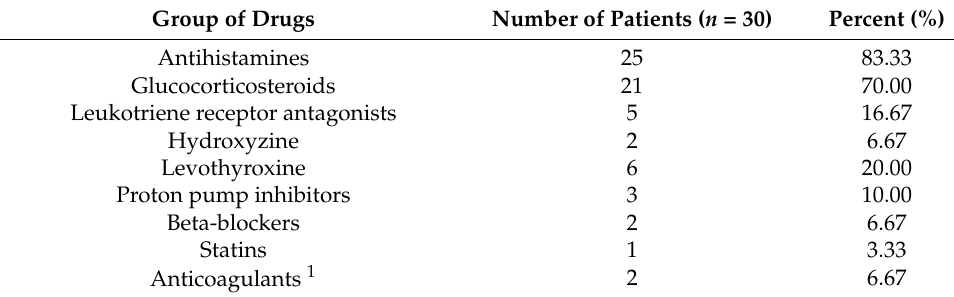
Table 2. Group of medication used by study